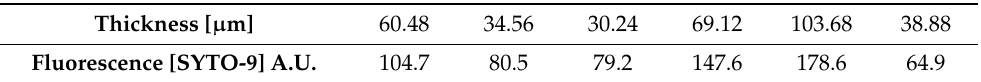
Table 1. The measured thickness of biofilm and the corresponding fluorescence level. A.U.—arbitrary units. Thickness [ µ m] Fluorescence [SYTO-9]